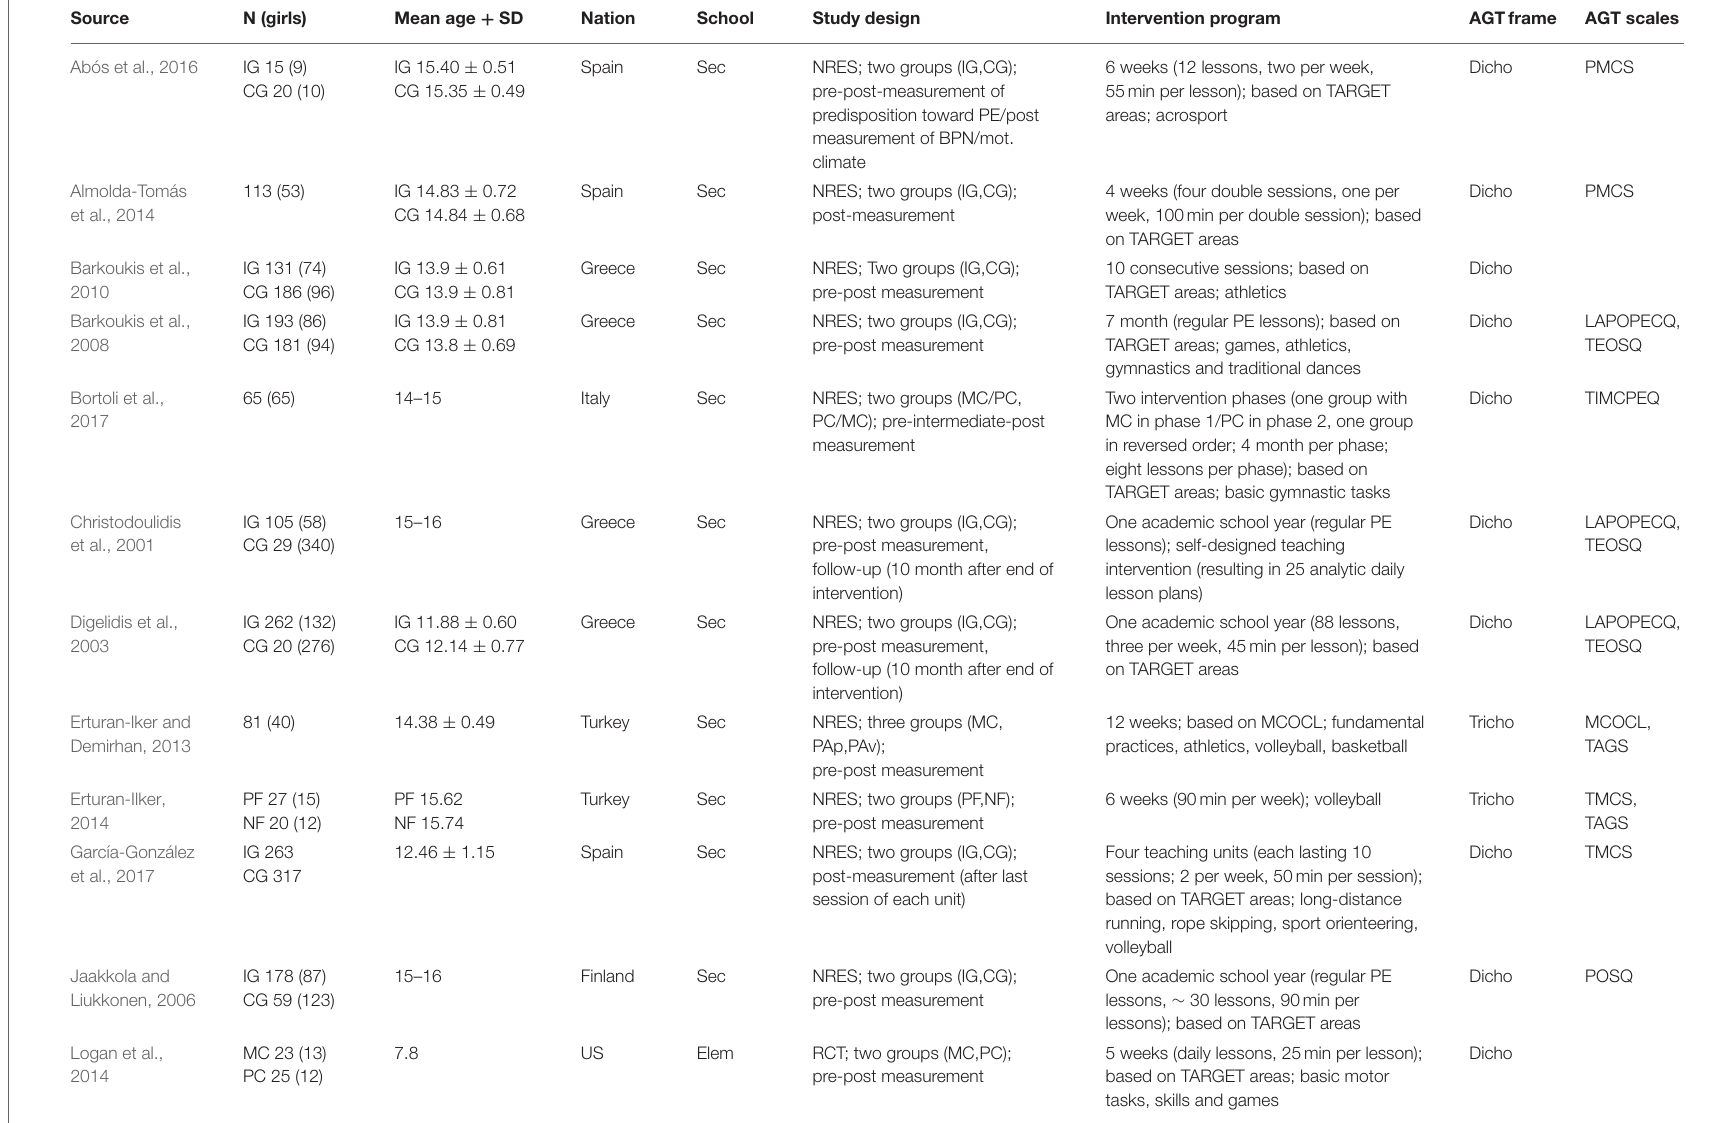
TABLE 2 | Descriptive characteristics of the included intervention